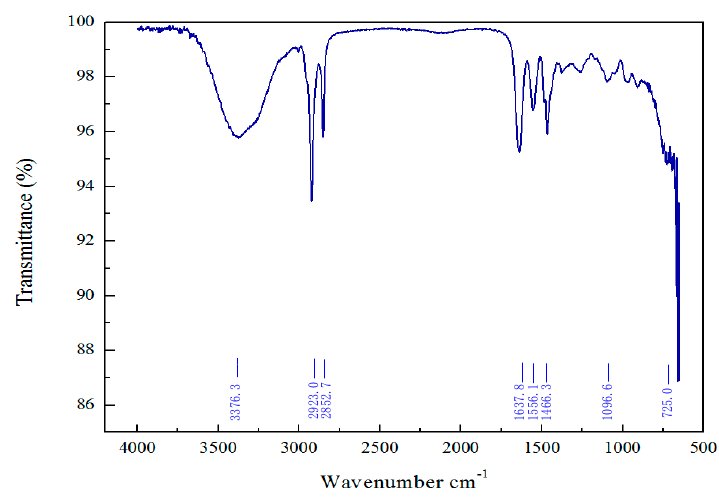
Figure 1. Fourier-transform infrared spectroscopy (FT-IR) spectra of VES-T.